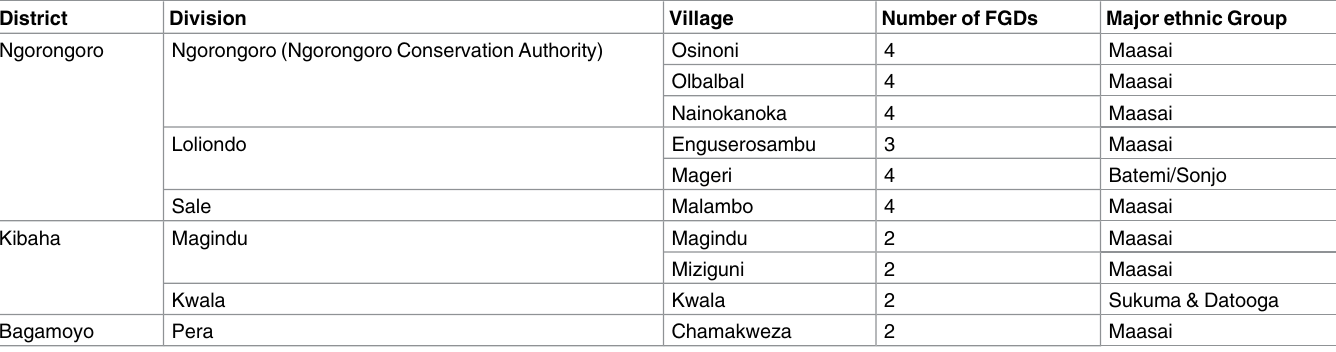
Table 3. FGDs per village, district, division and ethnic